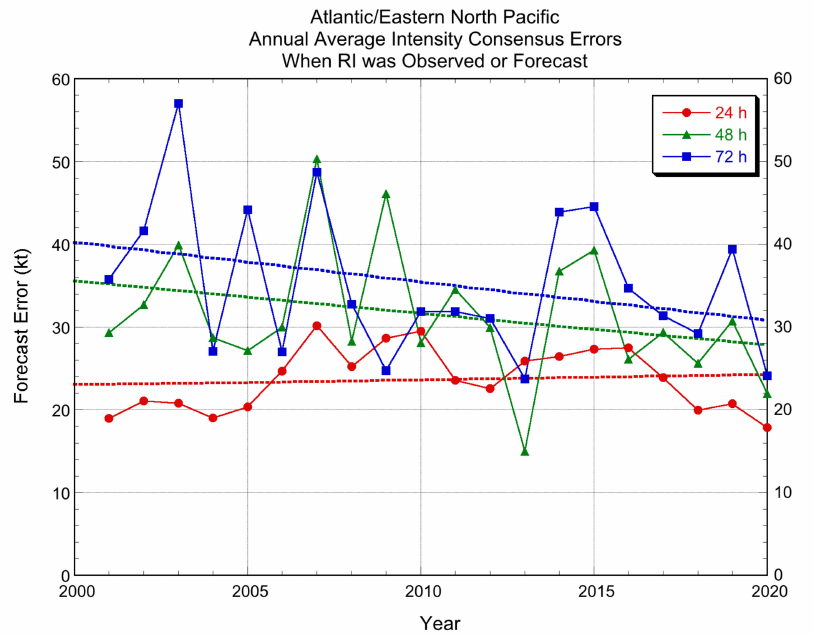
Figure 13. Historical annual average performance of IVCN, at 24, 48, and 72 h for the combined Atlantic and eastern North Pacific basins for the sample of cases when RI was either observed or forecast by any of the member models of IVCN. Least-squares trend lines are shown by dashed lines. Note that the verifications for the 2020 season are preliminary as not all of NHC’s post-storm best track analyses were complete at the time this manuscript was